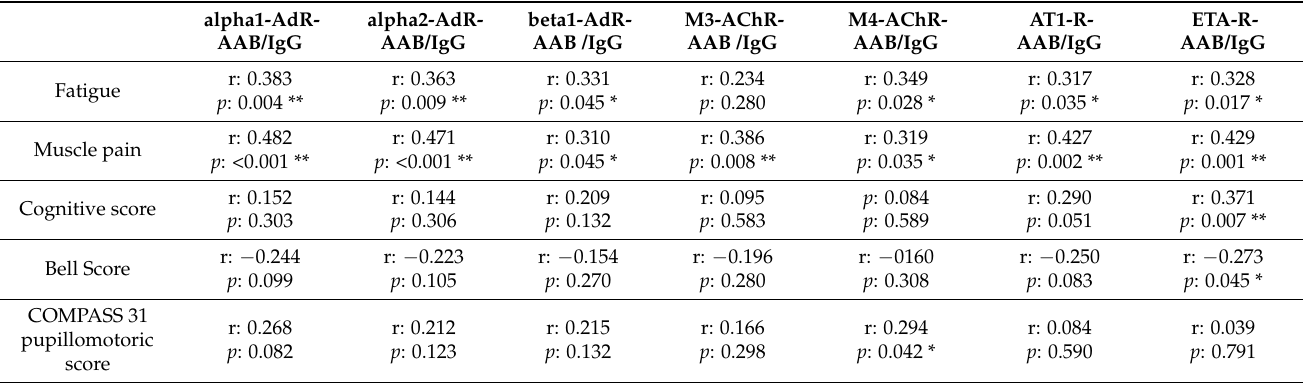
Table 3. Significant clinical correlations with AAB/IgG ratios after BH-correction in patients with infection-triggered onset (Spearman correlation coefficient and Benjamini–Hochberg corrected p -value; significant correlations marked with asterisks: * p < 0.05, ** p <